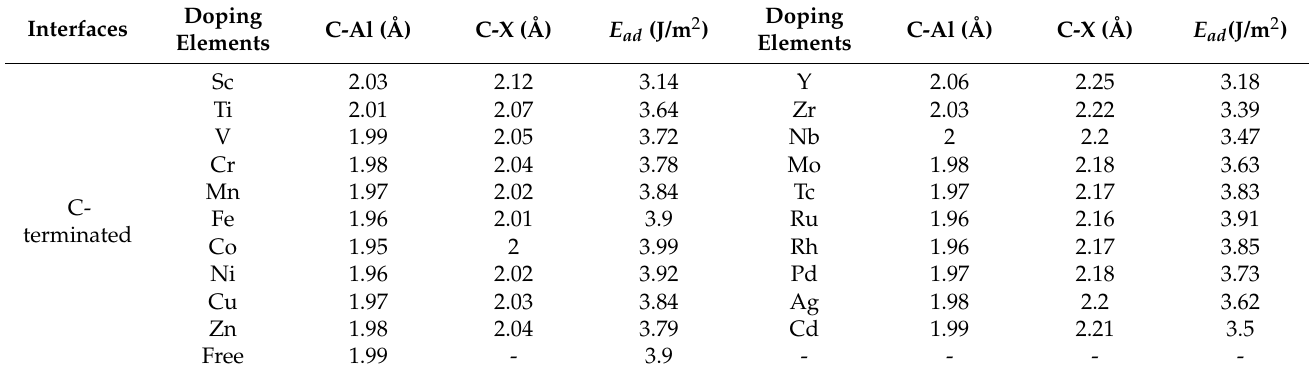
Table 2. Bond length (Å) and adhesion energy E ad J/m 2 ) at the Si-terminated Al-X (111)/6H-SiC (0001) interface. Doping Interfaces Si-Al (Å) Elements